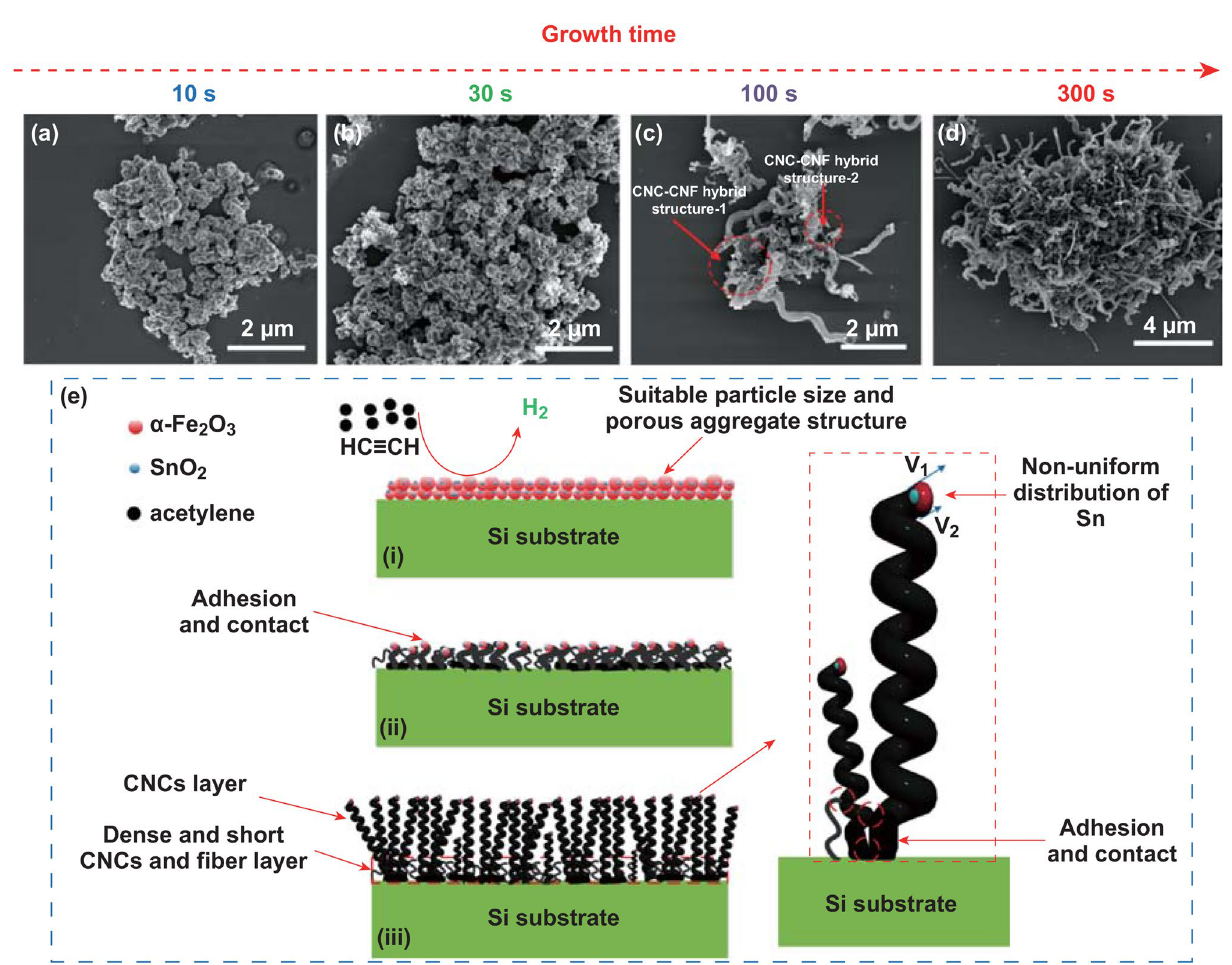
Fig. 7 SEM images of the catalyst aggregates and deposits on the substrates after feeding C 2 H 2 (4 sccm) at 710 °C for a 10 s, b 30 s, c 100 s, d 300 s. e Schematic of growth pathway of high-purity